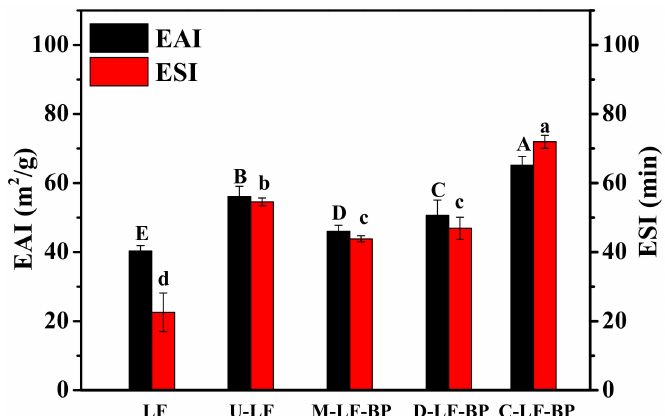
Figure 7. EAI and ESI of LF, U-LF, M-LF-BP, D-LF-BP and C-LF-BP. Bars with di ff erent letters